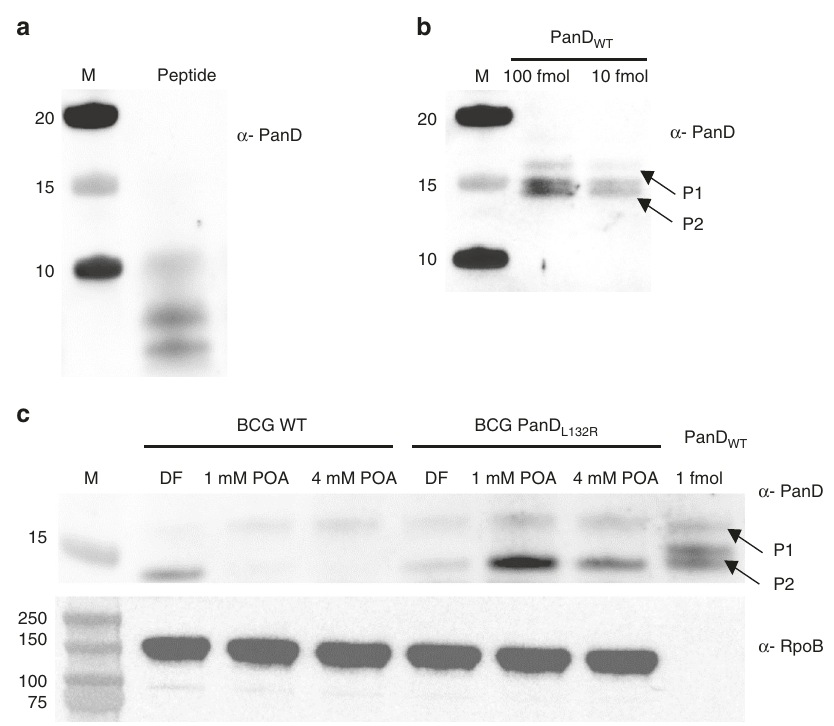
Fig. 4 Effect of POA treatment on PanD protein levels in wild-type and POA-resistant panD -mutant M. bovis BCG. a , b Western blots of 1 µ g PanD peptide IAYATMDDARARTY used as antigen, and 100 and 10 fmol puri fi ed recombinant PanD wild-type protein (PanD WT ), respectively. P2, cleaved C-terminal portion of PanD; P1 full-length proenzyme of PanD (see Fig. 1). Antiserum α -PanD against a PanD peptide was raised in rabbits and used to analyze protein levels of native PanD protein by western blotting. The cleaved N-terminal part of PanD (P3, Fig. 1) is not visible on the blot as the PanD peptide used to raise the antiserum is located within the P2 portion of the protein. As observed in Coomassie blue stained SDS-PAGE of puri fi ed recombinant PanD protein (Fig. 1), the cleaved form of P2 migrates as a doublet with similar staining intensity. The P2 doublet is speci fi c to recombinant protein and is not observed in whole cell extracts (see c ). c M. bovis BCG wild type (BCG WT) and POA-resistant M. bovis BCG PanD L132R harboring a Leu132Arg mutation in its C-terminal tail 6 were either not treated with POA (DF drug free) or treated with 1 or 4 mM POA for 24 h. Ten micrograms of respective total protein extracts was subjected to western blot analyses. Upper panel: probing with α -PanD. PanD WT , 1 fmol of recombinant PanD wild-type protein was included as molecular weight marker. Lower panel: probing of the blot showed in the upper panel with antiserum against mycobacterial RNA polymerase subunit RpoB ( α -RpoB) to show equal loading. M, Marker with molecular weights (kilodalton) are indicated. Experiments were repeated two times independently, yielding the same results. The results from a representative experiment are shown. Taken together, these data show that treatment with POA causes a reduction of the intrabacterial level of wild-type PanD but does not affect the intrabacterial level of a non-POA binding resistant mutant of PanD. Consistent with the overall low intrabacterial levels of PanD indicated by our western blotting experiments, PanD was not detectable in previous proteome analyses (<1 fmol/ µ g), whereas all other CoA pathway enzymes could be quanti fi ed (1 – 6 fmol/ µ g) 29 . We con fi rmed this fi nding by shotgun proteomic analyses of mycobacterial whole cell extracts in which CoA pathway enzymes other than PanD were readily detectable, including the pantothenate synthetase PanC (Supplementary Data 2_Proteomic